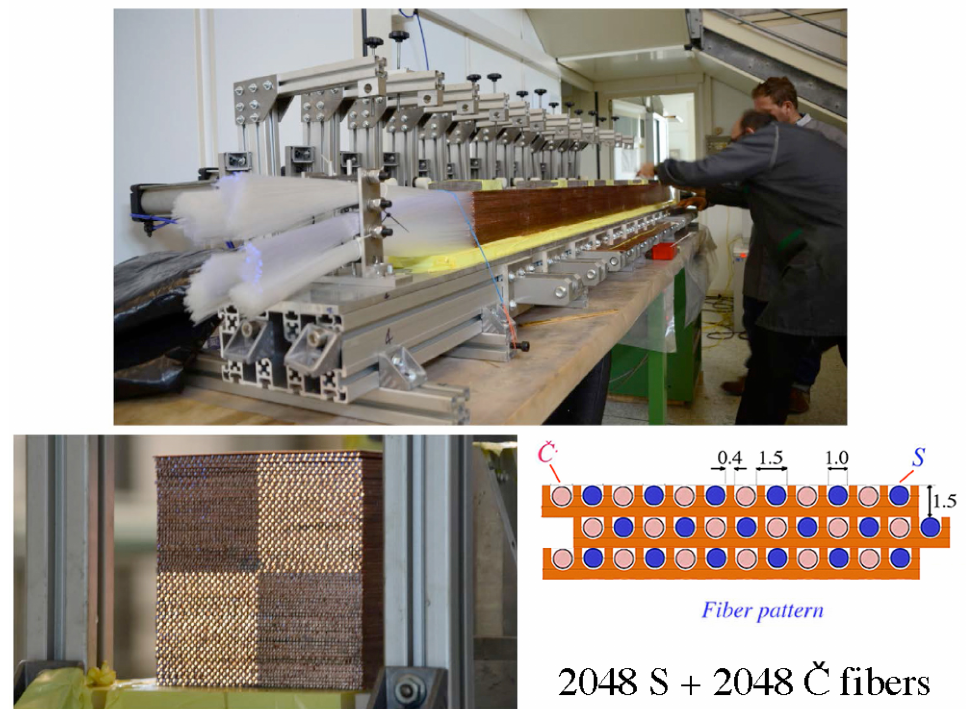
Figure 11. A fine-sampling copper-fiber calorimeter built by the Pisa group of the RD52 Collaboration.